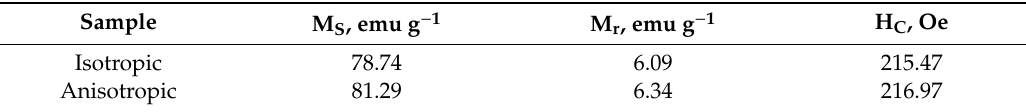
Table 3. Magnetic properties of isotropic and anisotropic